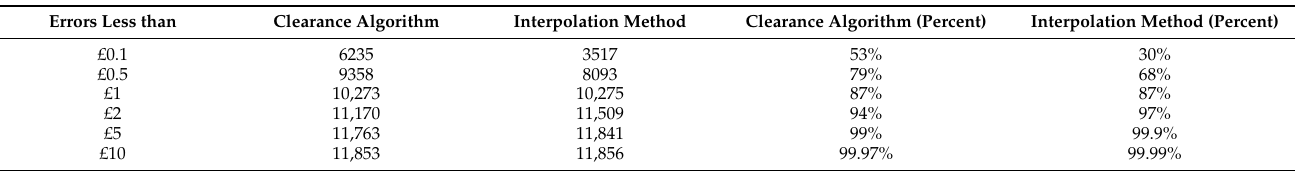
Table A2. Showing the number of estimates whose errors are less than the different price amounts. Additionally included are the percentages.